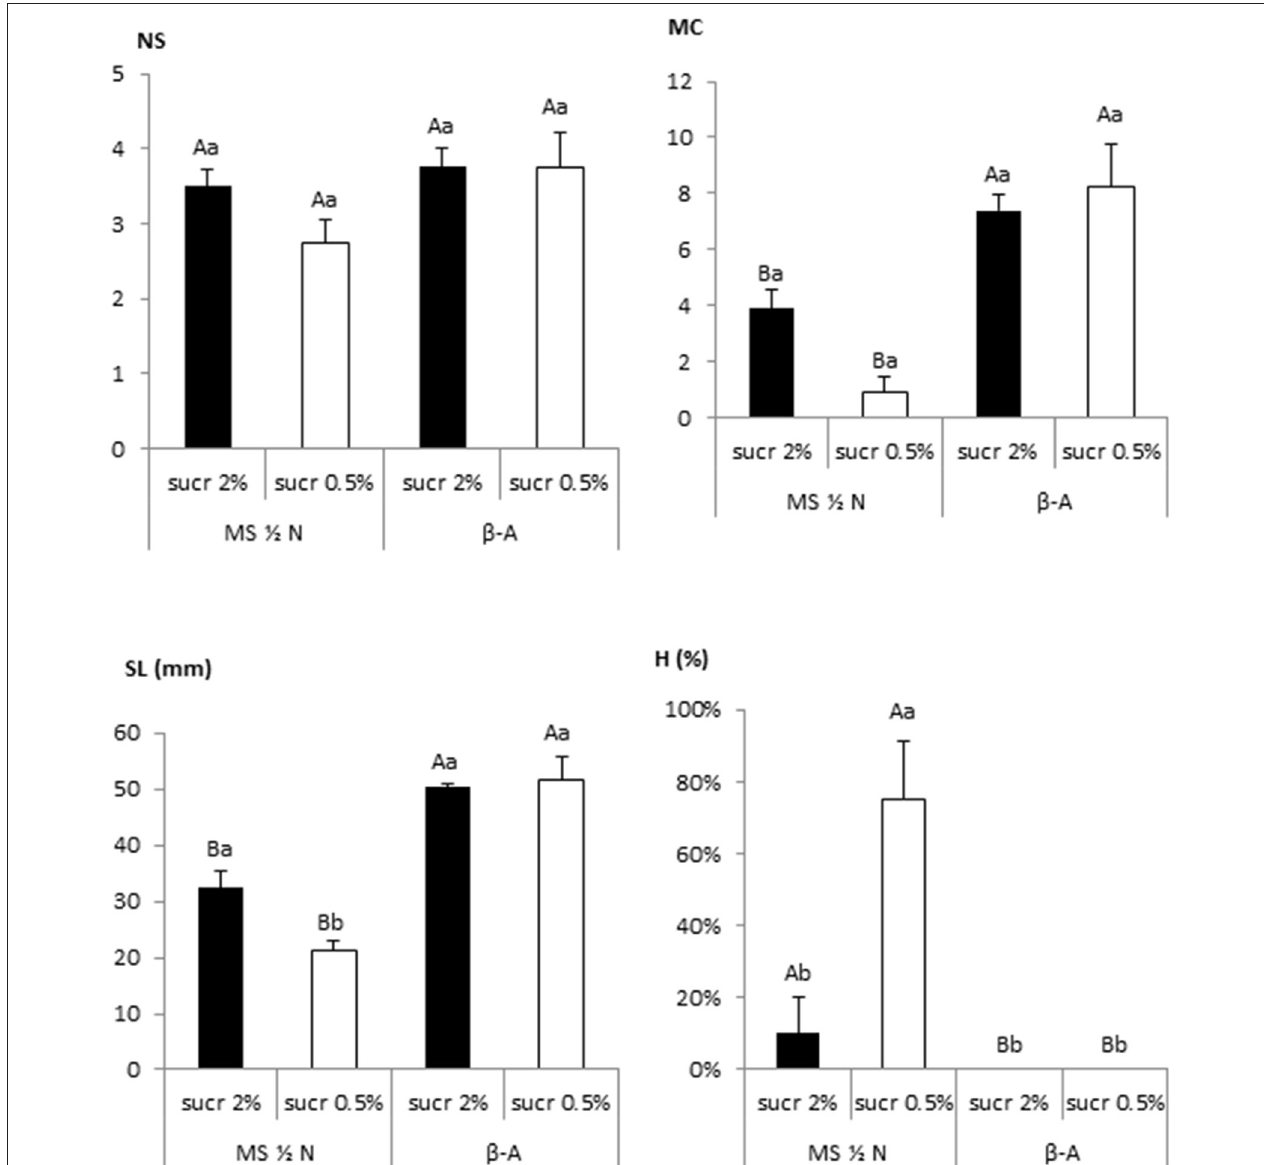
FIGURE 5 | Effect of sucrose and mineral medium on the growth of 8 apical sections of Beatriz genotype cultured in RITA ® vessels. Explants were grown in MS medium with half-strength nitrates and in β -A medium, both supplemented with 2- µ M metatopoline and 2 or 0.5% sucrose. The data were recorded after 4 weeks of culture. The values represent the mean ± standard error. For each variable, different uppercase letters indicate significant differences in relation to the medium, and different lowercase letters indicate significant differences in relation to sucrose supplementation ( p < 0.05). NS, number of shoots per explant; MC, multiplication coefficient; SL, length of the longest shoot (mm); H, percentage of hyperhydric